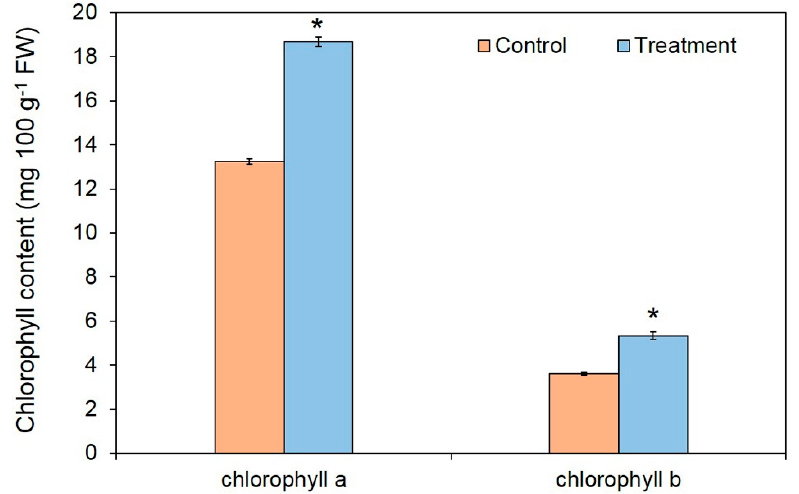
Figure 4. Chlorophyll a and b contents of A. thaliana exposed to T. asperelloides PSU-P1 VOCs and without VOCs. Asterisks indicate statistically significant di ff erences (* p < 0.05) using the Student’s t - test .